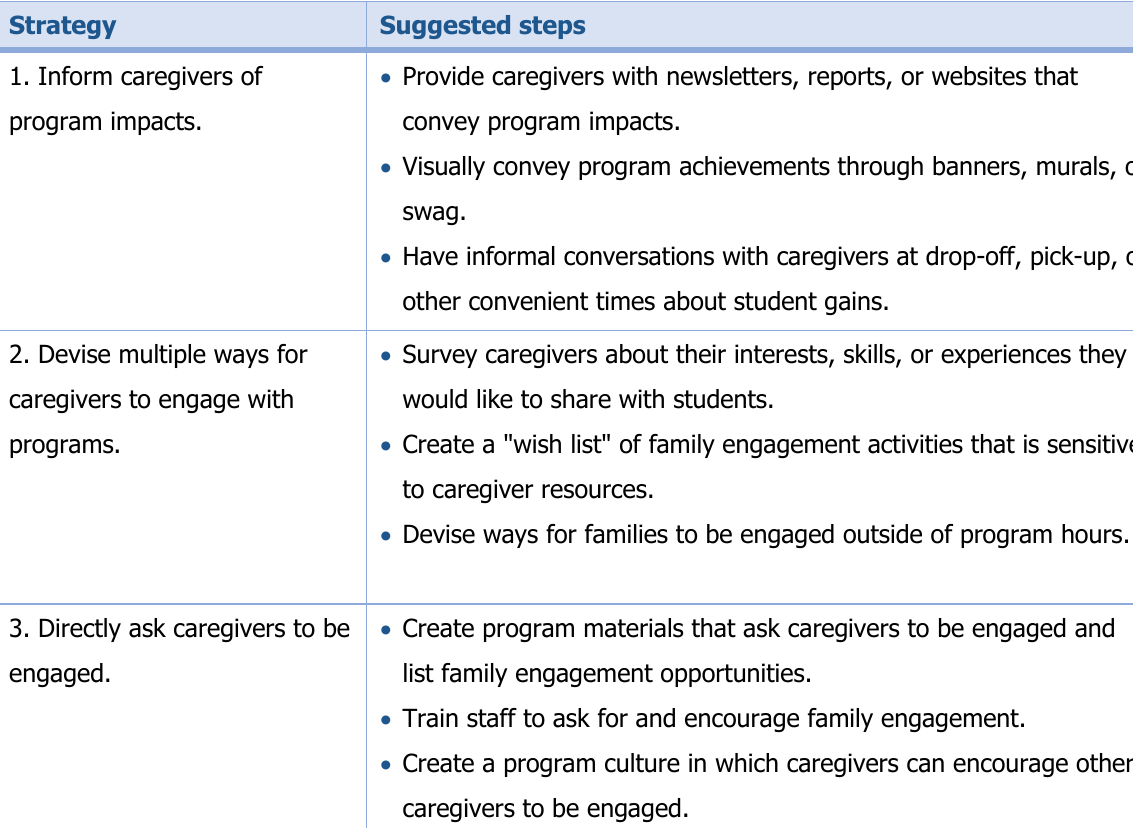
Table 1. Strategies After-School Programs Can Use to Engage Black Families